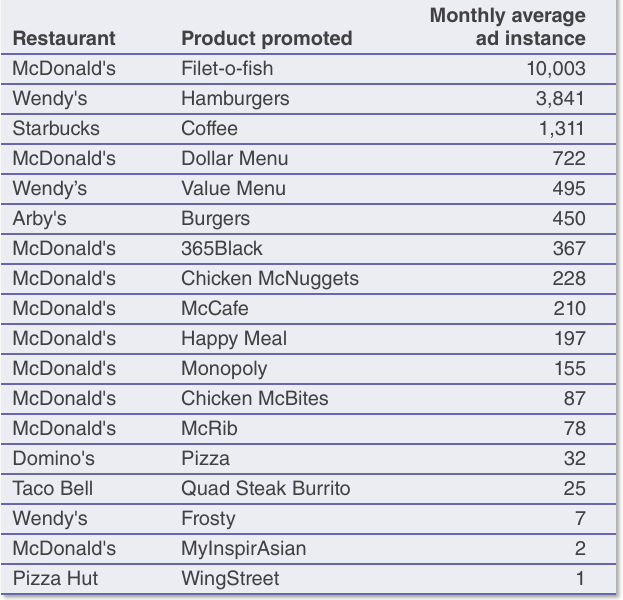
Table 34. Mobile display ad instance by menu item or product